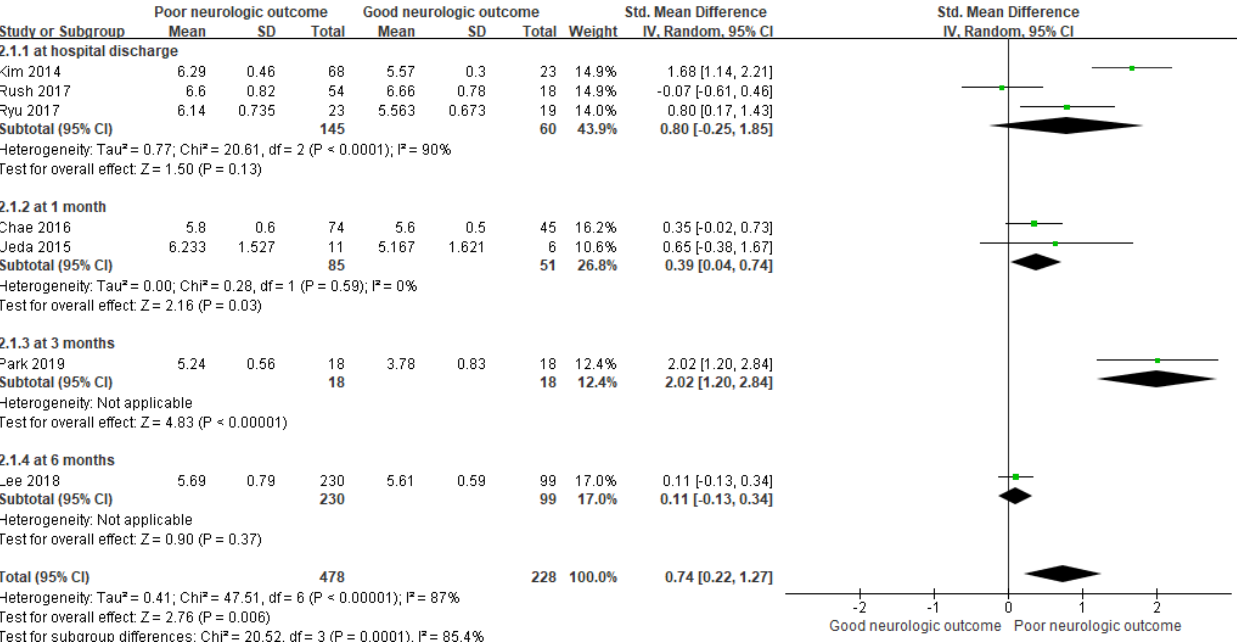
Figure 2. Forest plot for the association of ONSD with a poor neurological outcome [1,6,17–21]. Abbreviations: CI = confidence interval; ONSD = optic nerve sheath diameter; SD = standard